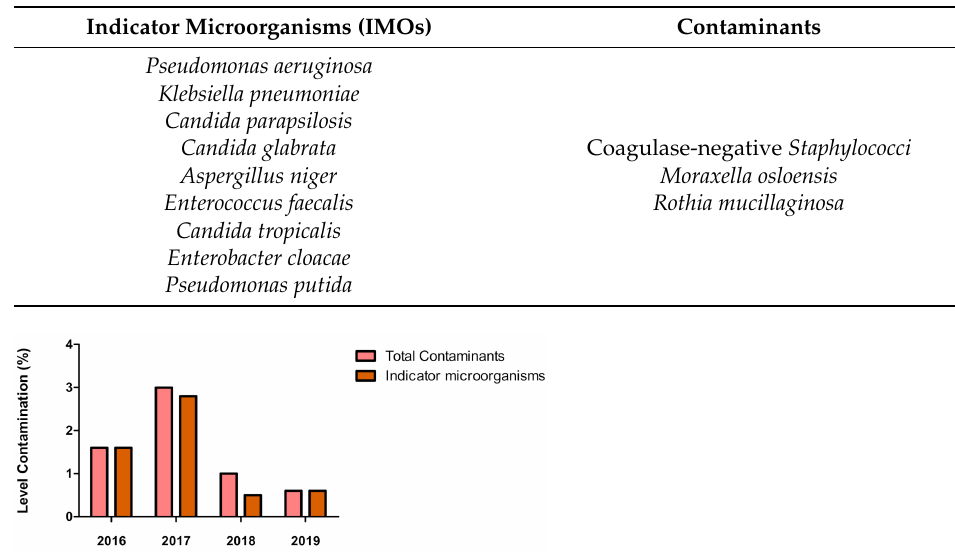
Table 4. IMOs and contaminants in colony forming units (CFU ≥ 10) found in the endoscopes tested